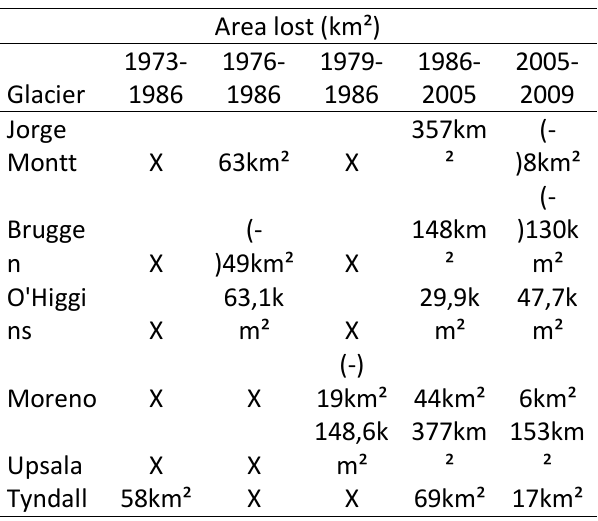
Table 1. Loss of frontal area of the glaciers due to retreat -